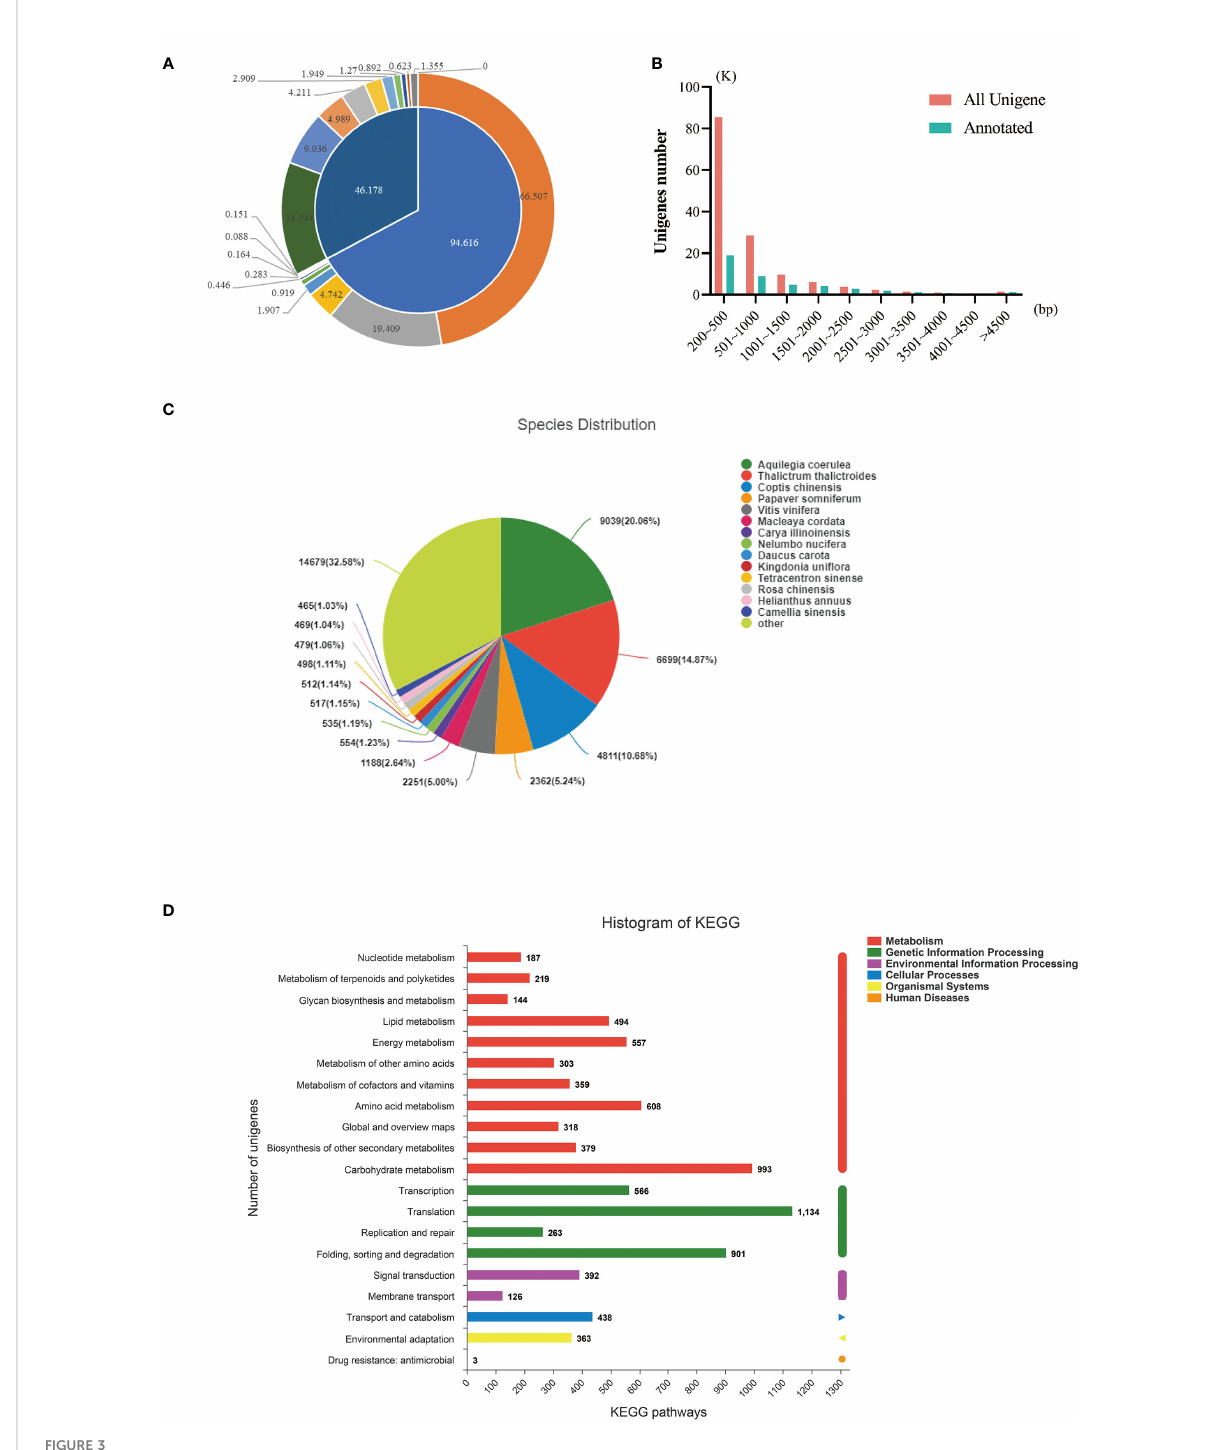
FIGURE 3 De novo assembly and functional annotation of transcriptome sequencing. (A) The overview of sequencing data annotation; (B) Length distribution statistics of annotated and unannotated unigenes; (C) NR annotation result; (D) KEGG annotation results. Note:K means its number is 1000;bp means base